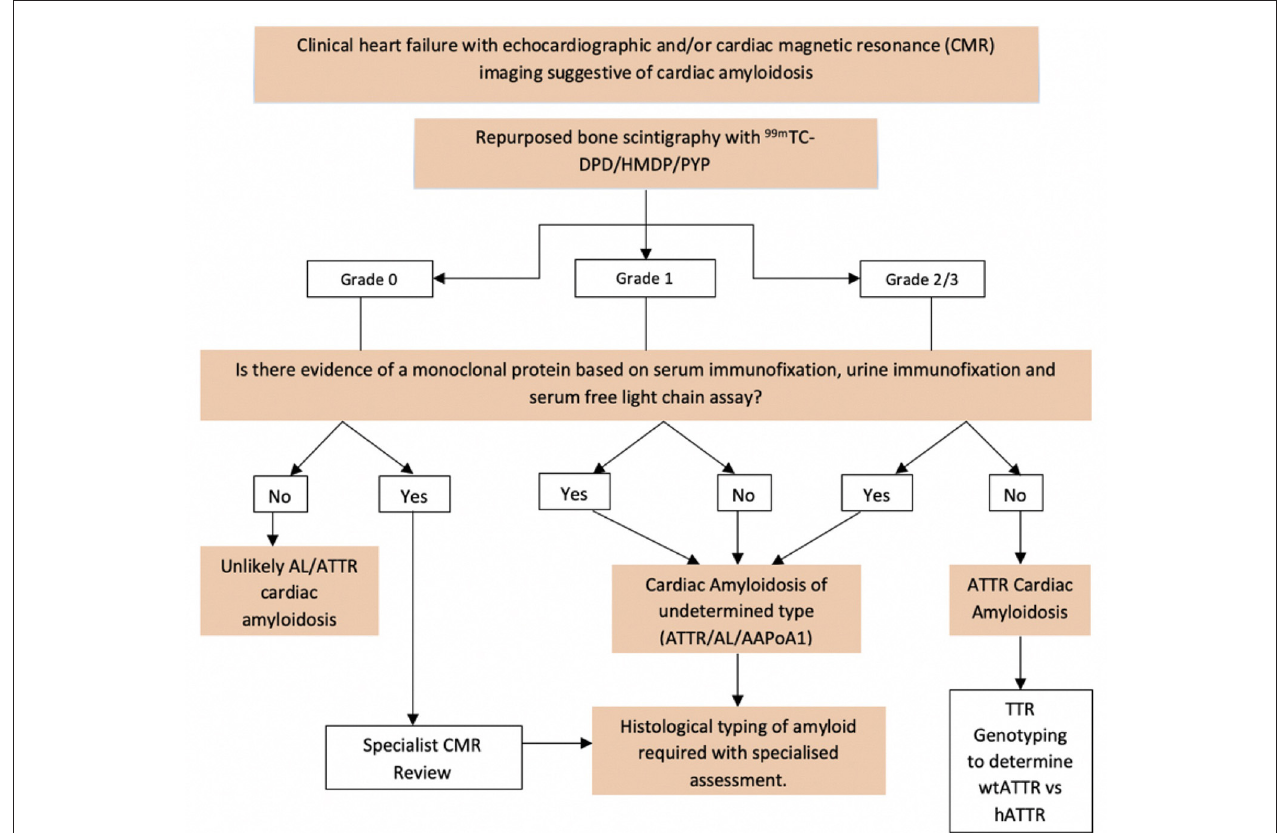
FIGURE 4 | Non-invasive diagnostic algorithm and criteria for investigating patients with suspected CA. Echocardiographic features suggestive of CA include LV wall thickening, “speckled myocardium,” reduced global longitudinal strain with apical sparing and diastolic dysfunction. CMR features of CA include increased LV wall thickness and mass, elevated T1 values, subendocardial and/or transmural LGE in a diffuse circumferential pattern and elevated ECV measurements. In patients with a plasma cell dyscrasia and cardiac uptake on DPD, histological confirmation by way of cardiac biopsy is almost always required in order to confirm amyloid type (AL vs. ATTR) and guide appropriate therapeutic decisions. Equally, invasive histology is not required to confirm the diagnosis of ATTR CA should the appropriate imaging and biochemical criteria be met (Grade2/3 uptake on Tc-DPD, normal free light chains and immunofixation)